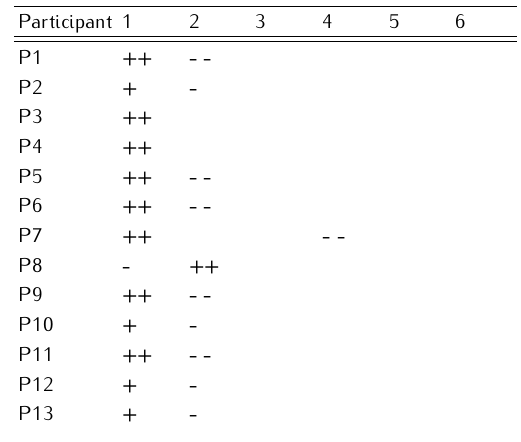
Table 4. The spatial formations that occurred in situation S3. The symbols in- dicate how much time was spent in each formation: - -. 0-10%, -.